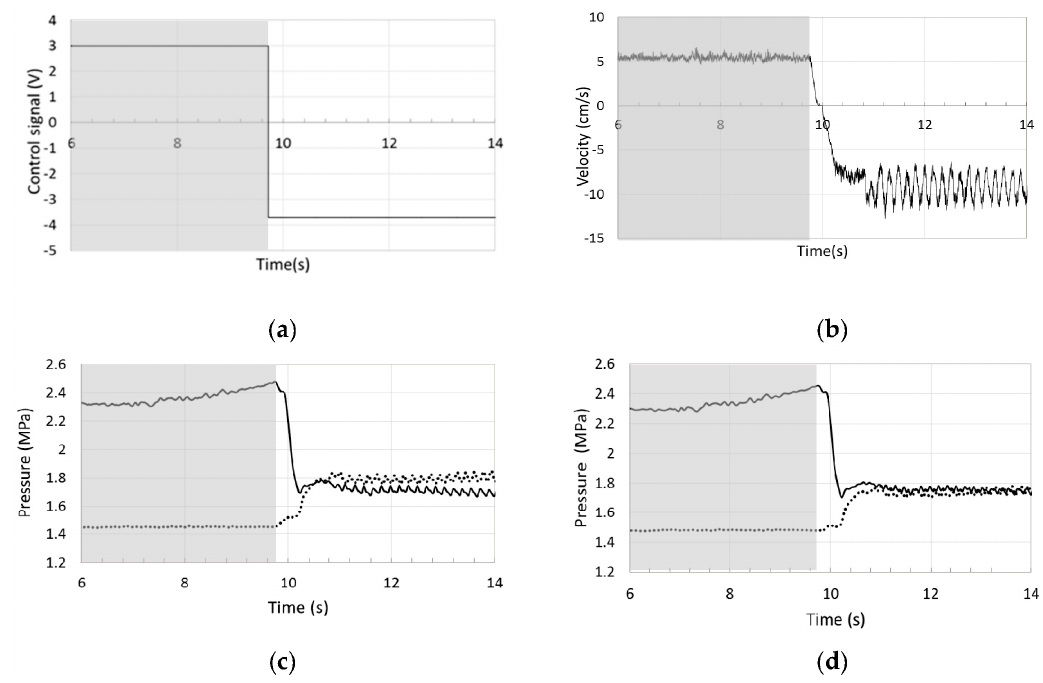
Figure 6. Performance of circuit with POCVs only in extension and retraction of a 245 kg attached mass: ( a ) control signal; ( b ) actuator velocity; ( c ) pressures at pump port a (solid line) and port b (dotted line); and ( d ) pressures at actuator port a (solid line) and port b (dotted line).